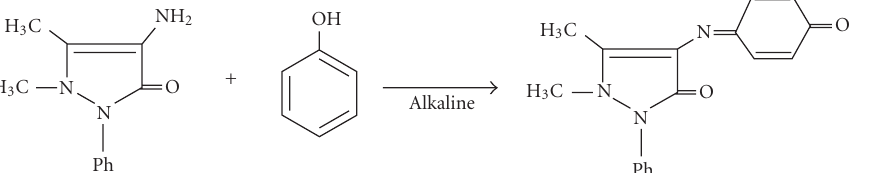
Figure 2. Coupling reaction between phenyl and